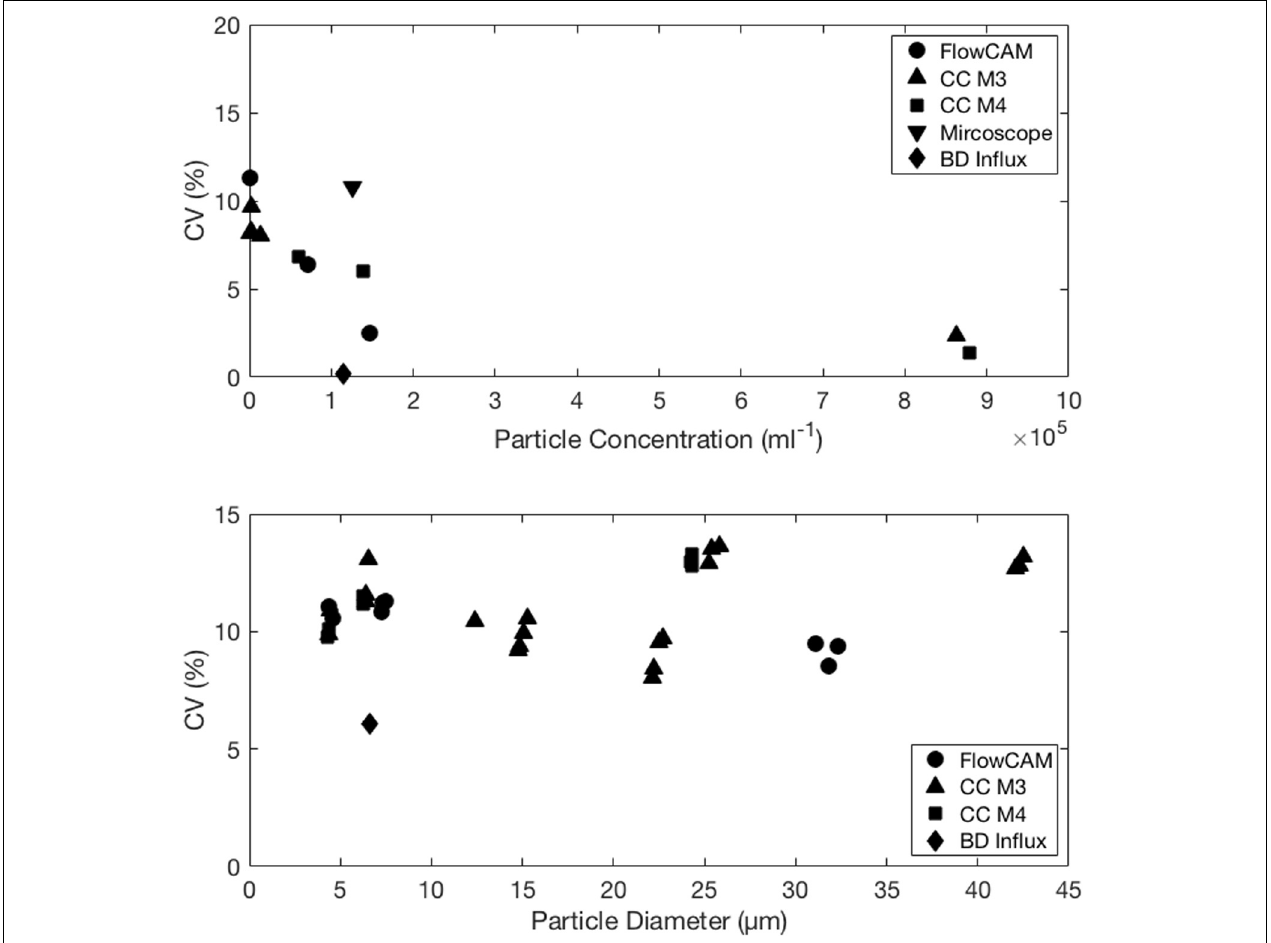
FIGURE 2 | Consistent coefficient of varition (CV, %) among (top) concentration and (bottom) particle size measurements for phytoplankton ranging from < 5 to > 40 µ m in diameter measured with five different instruments. Coefficient of variation did not exceed 10 and 15%, respectively, of the abundance or size measurement and was independent of instrument and particle size. Particle counts in excess of 400,000 ml − 1 did have a lower CV but are measured at the risk of high conincident particle passages.